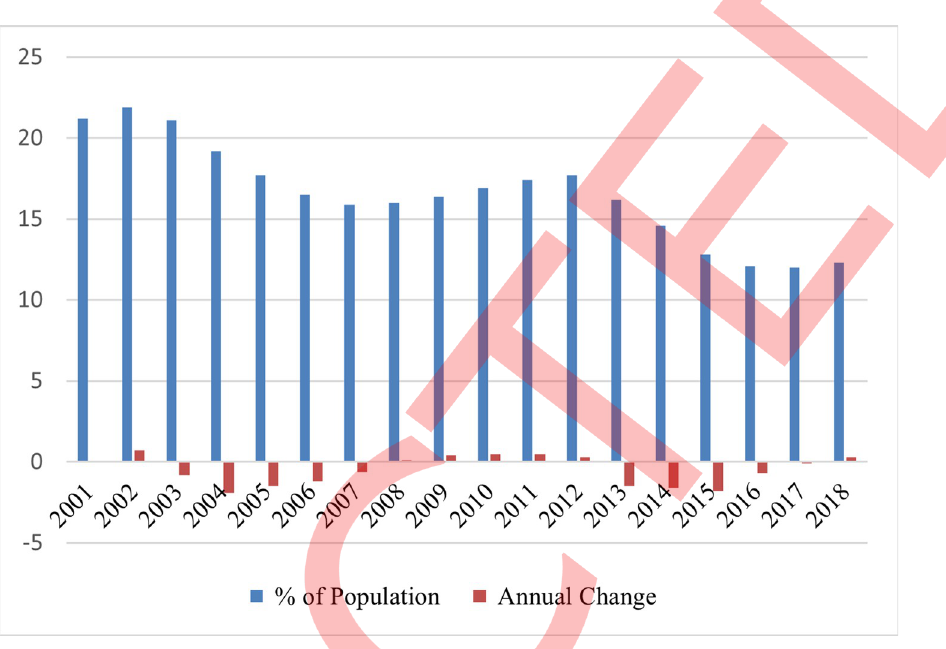
Fig 1. Pakistan hungers statistics. Source: Made by the author based on the data from world development indicators.